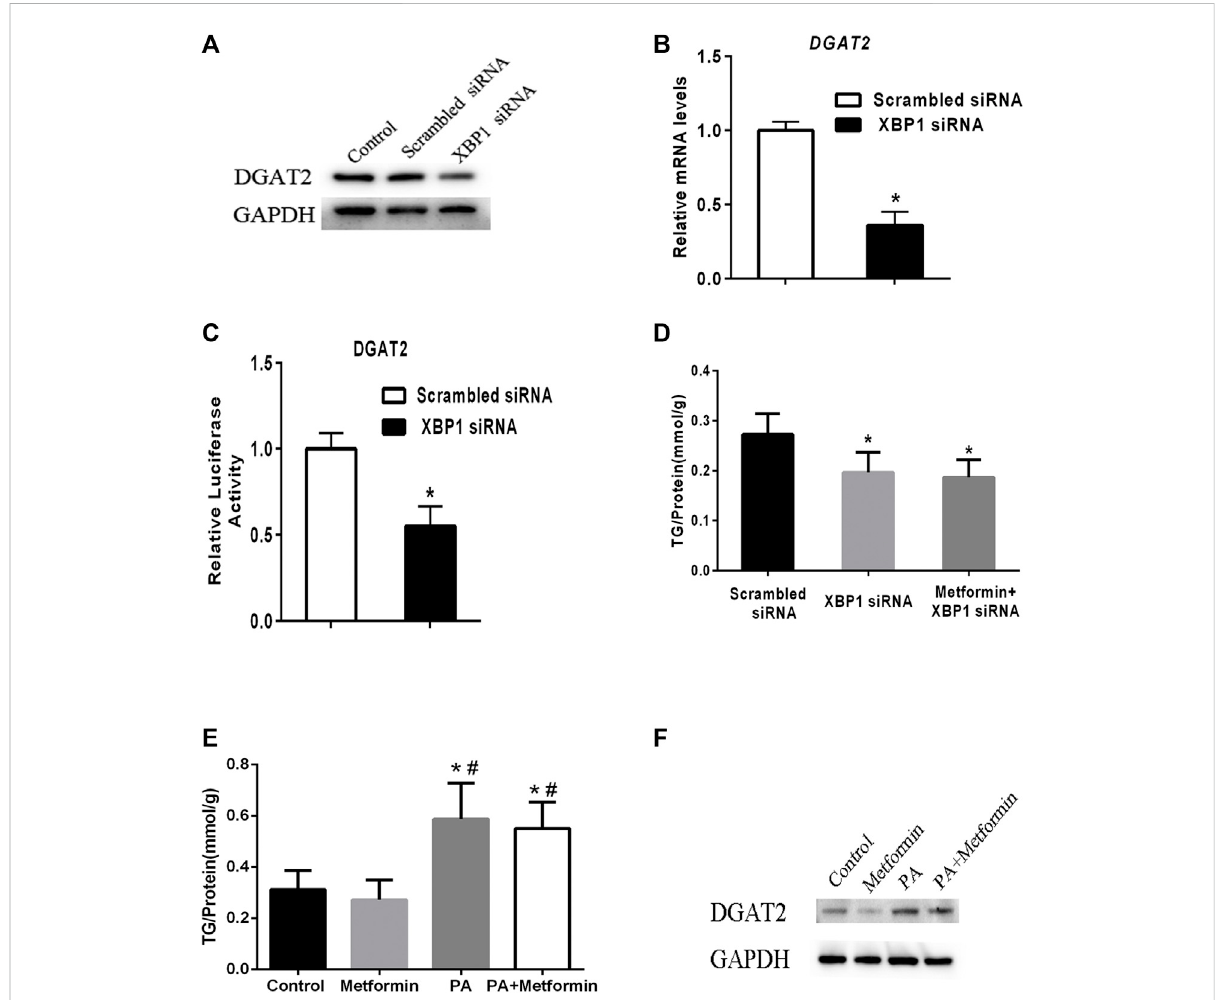
FIGURE 4 Metformin decreased TG synthesis by regulating XBP1-mediated DGAT2 expression. (A) HepG2 cells were transfected with small interfering RNAs targetingXBP1 (XBP1 siRNA)or ascrambled siRNA(control siRNA) or vehiclecontrol for 48 h. DGAT2 proteins levels were analyzed bywestern blotting. (B) RelativemRNAleveland (C) relativeluciferaseactivityofDGAT2inHepG2cellstransfectedwithXBP1siRNAorscrambledsiRNAfor48 h p p < 0.05 compared with scrambled siRNA. (D) TG content in HepG2 cells transfected with scrambled siRNA or XBP1 siRNA with or without metformin for 48 h p p < 0.05 compared with scrambled siRNA. (E) The intracellular TG contents were measured in XBP1 knockout AML12 hepatocytes treated with 2 mmol/L metformin with or without 200 μ M palmitic acid (PA) for 48 h. (F) The DGAT2 proteins were determined. p p < 0.05 compared with control cells. #p < 0.05 compared with metformin-treated cells. Data are presented as the mean ± SEM. All experiments were conducted in